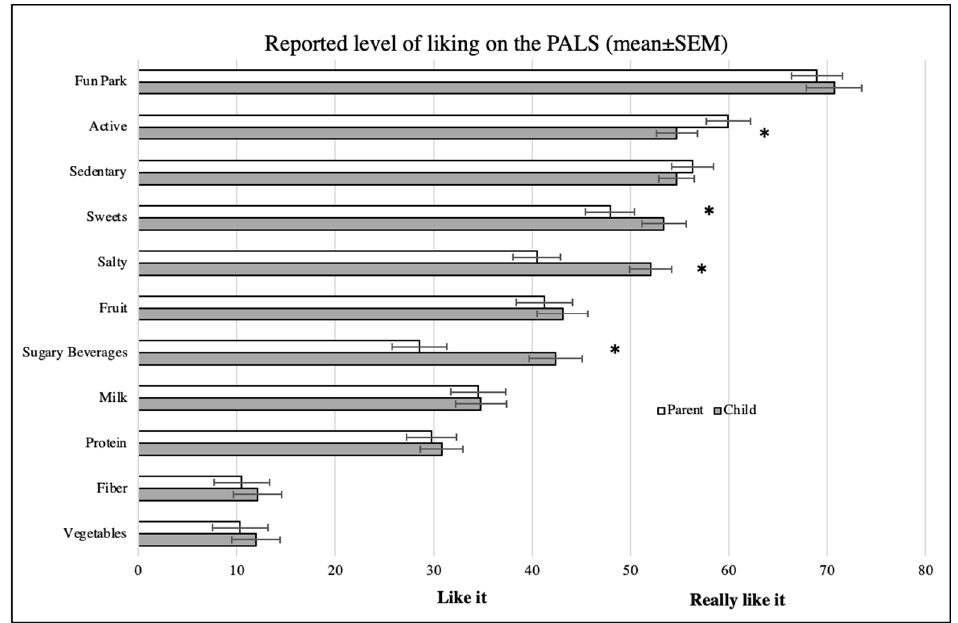
Figure 2. Reported level of liking on the pediatric-adapted liking survey (PALS) by parents and children (mean ± SEM). * Indicates significant mean differences ( p < 0.05).